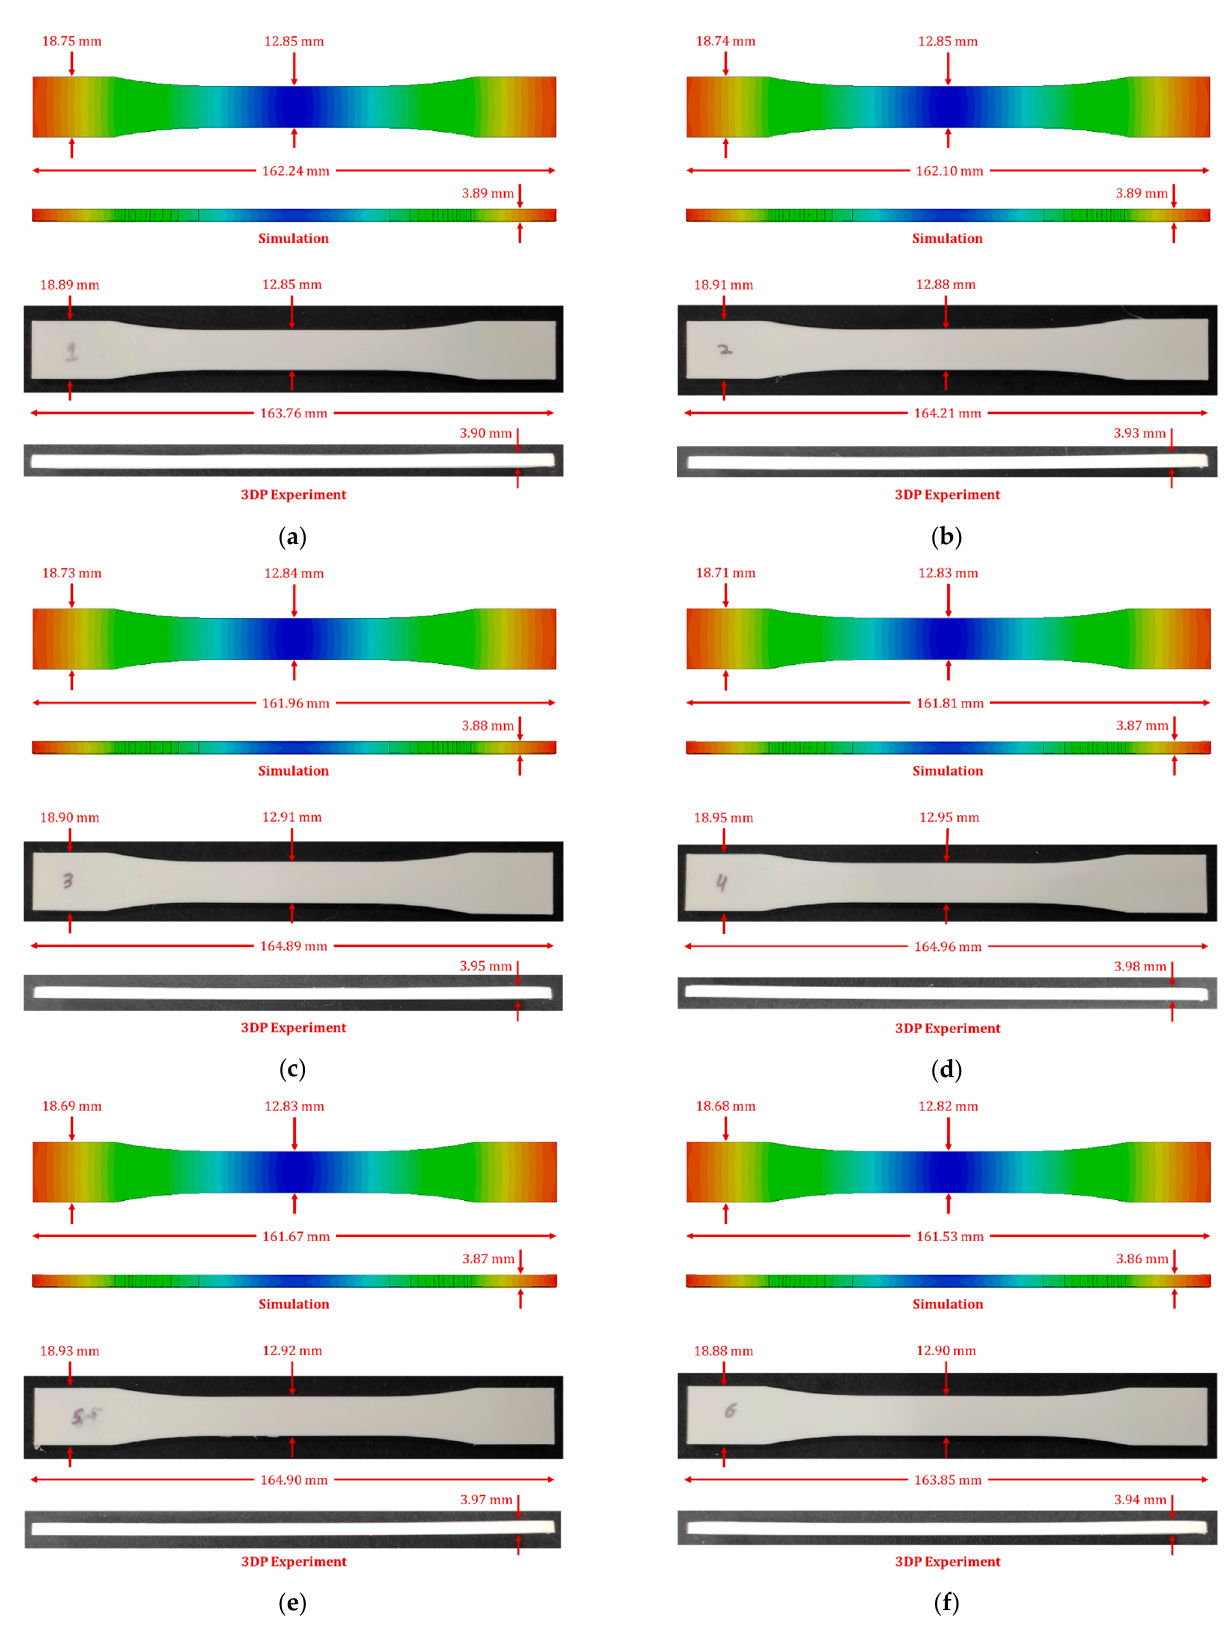
Figure 3. Specimen Dimensions for Numerically Predicted and Fabricated Samples 3D Printed at Figure 3. Specimen dimensions for numerically predicted and fabricated samples 3D printed at Different Temperatures ( a ) 210 °C ( b ) 220 °C ( c ) 230 °C ( d ) 240 °C ( e ) 250 °C ( f ) 260 °C. different temperatures: ( a ) 210 ◦ C, ( b ) 220 ◦ C, ( c ) 230 ◦ C, ( d ) 240 ◦ C, ( e ) 250 ◦ C, ( f ) 260 ◦